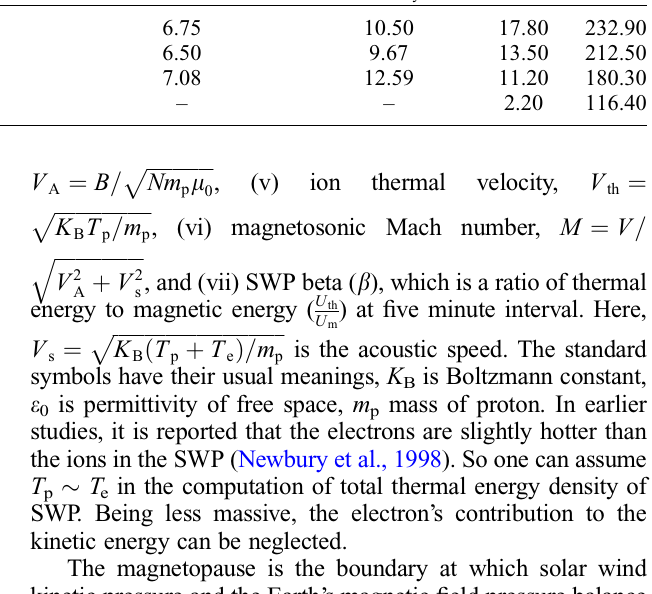
Table 1. SC characteristics namely start time, peak time, ascent time, descent time, length, peak sunspot number, and minimum sunspot number are given for SCs 21–24. Version-2 series of international sunspot number is used to obtain these characteristics. SC